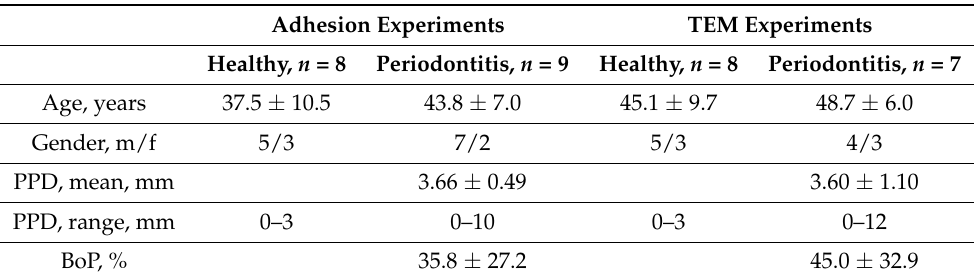
Table 1. Demographic characteristics and clinical parameters of study groups. Data are presented as mean ± SD. TEM, trans-endothelial migration; PPD, probing pocket depth; BoP, bleeding on probing. PPD and BoP were calculated based on the data measured at 6 sites of each present